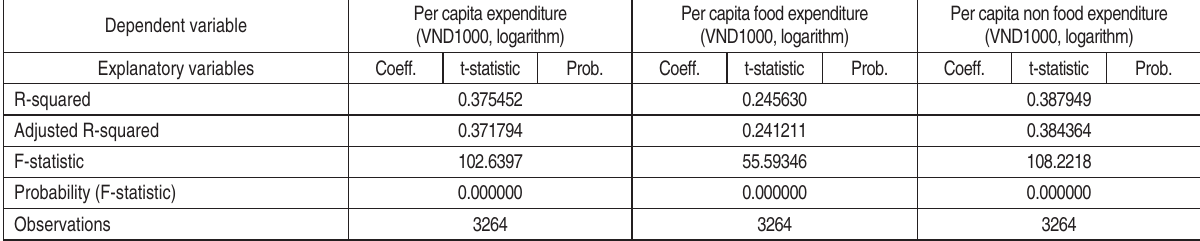
Table 5 (cont.). Second stage least squares regression: effect of credit on household